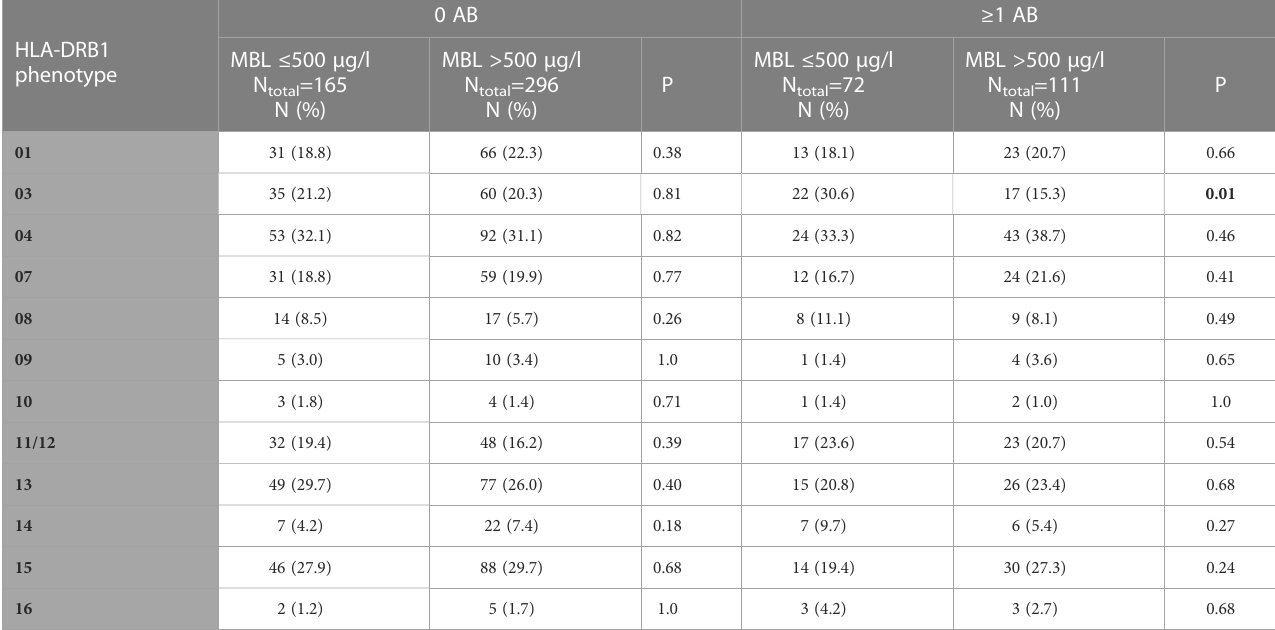
TABLE 3 The frequency of carrying at least one of the HLA-DRB1 alleles in patients grouped according to presence or absence of at least one of the investigated autoantibody classes and low or normal plasma MBL